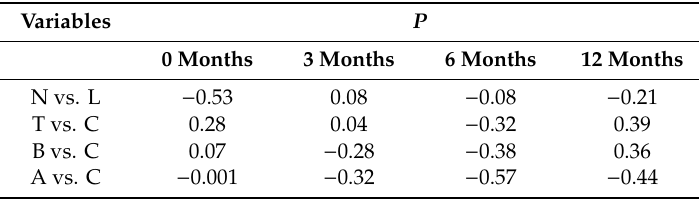
Table 1. Pearson’s correlation ( ρ ) between neutrophils (N), lymphocytes (L), testosterone (T), cortisol (C), beta-defensins (B), and alpha-defensins (A) at different analyzed times. The Pearson index was considered signi fi cant for values between +1 and − 1.